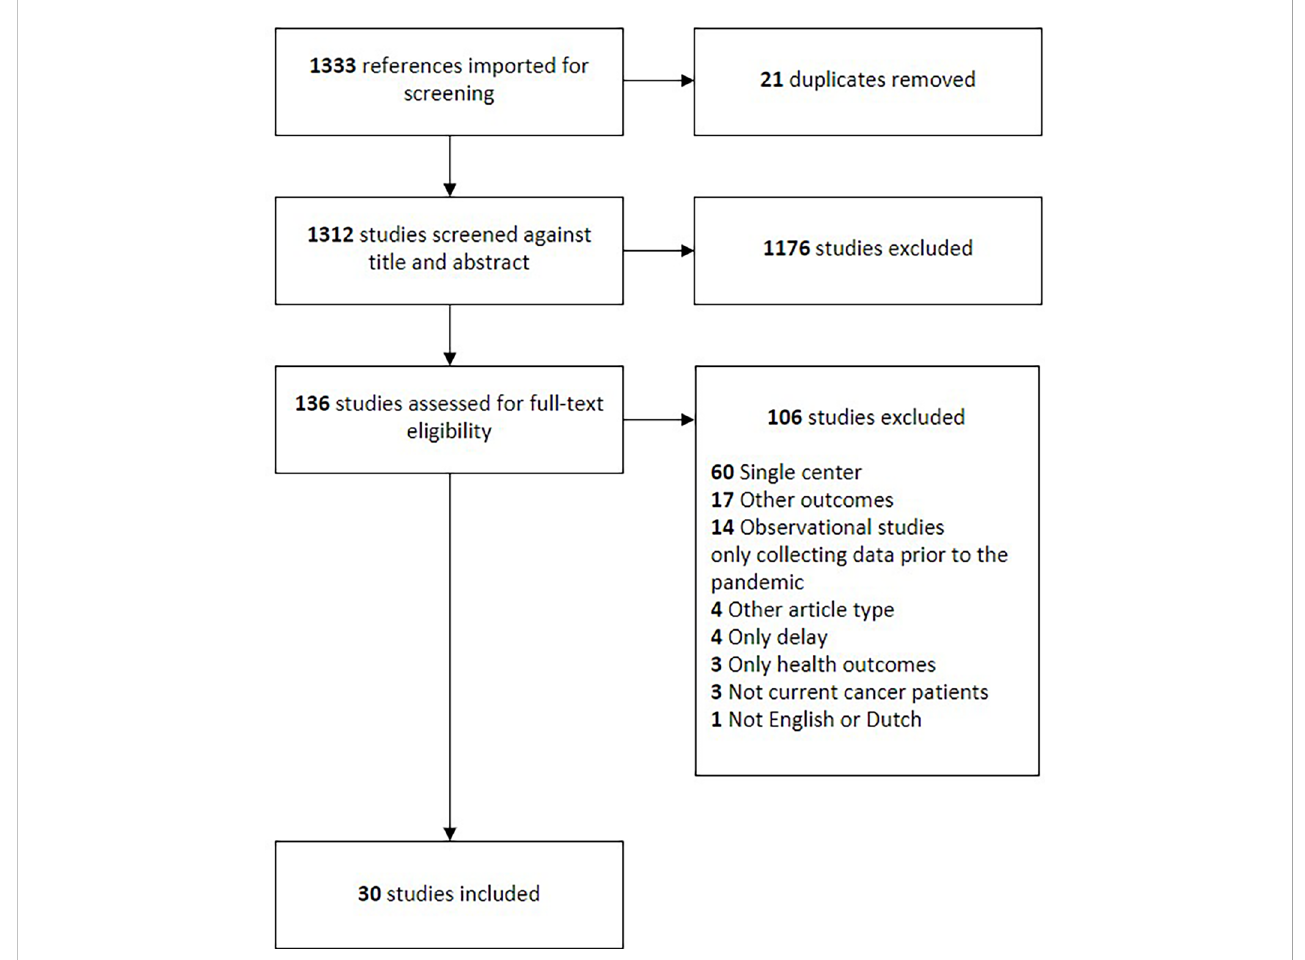
FIGURE 1 Flow chart of the screening process and the inclusion and exclusion